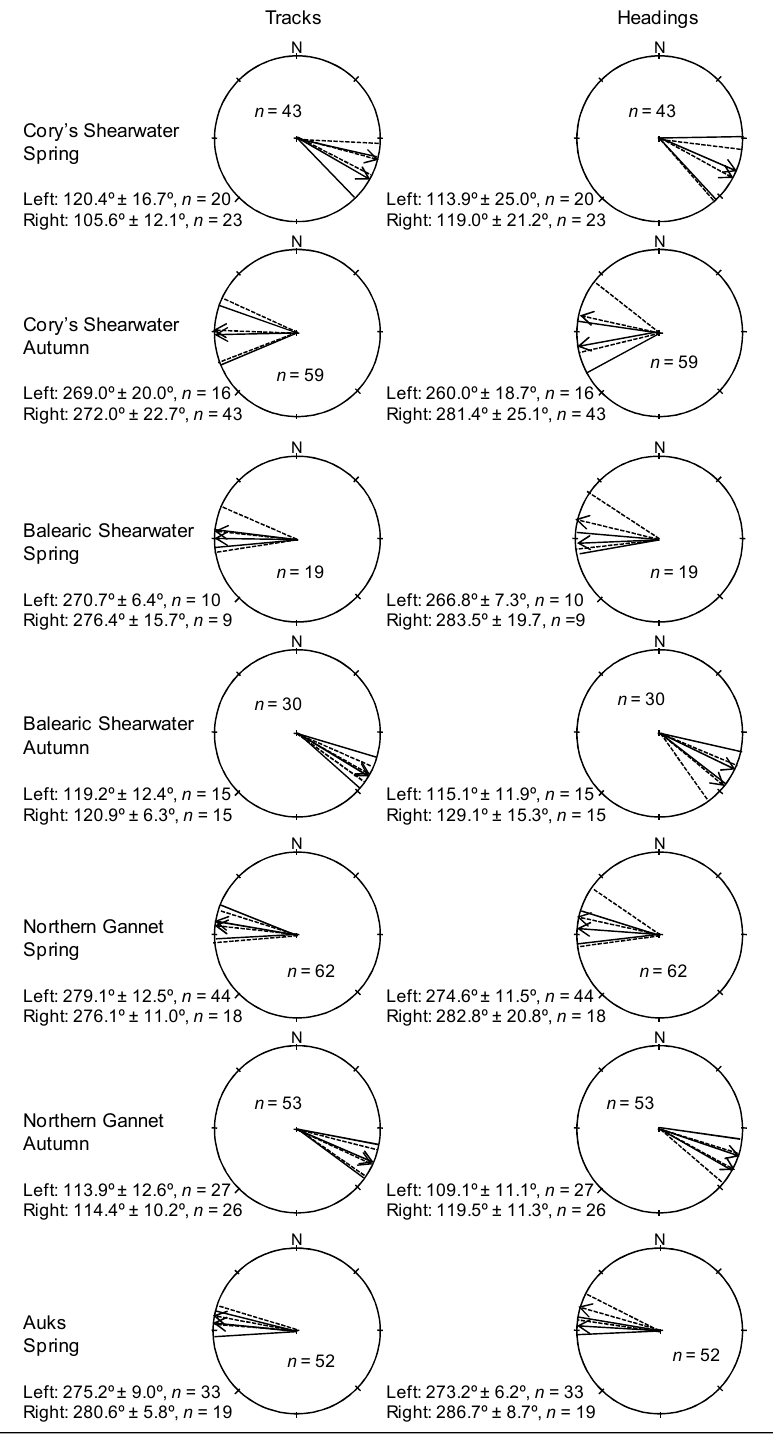
Left: 120.4º ± 16.7º, n = 20 Right: 105.6º ± 12.1º, n = 23